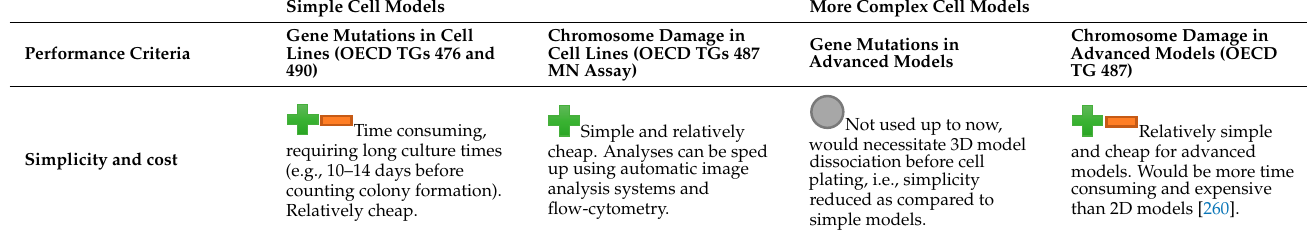
Table 1. Evaluation of suitability of cytotoxicity assays for SbD hazard testing.